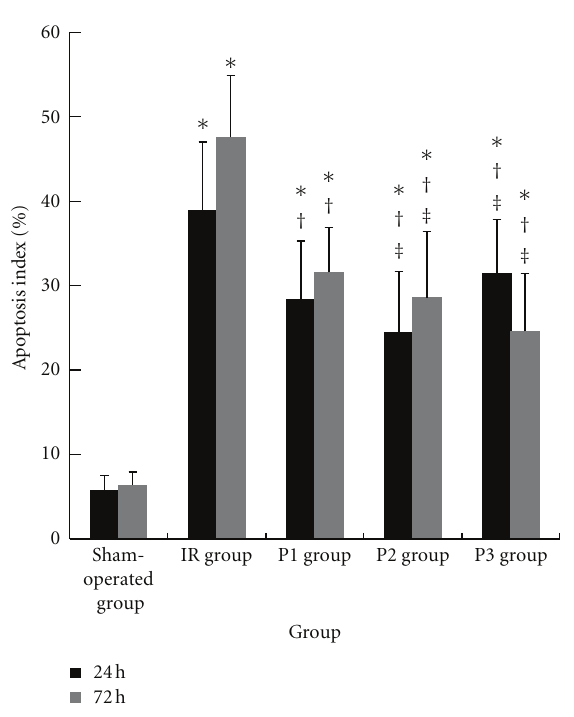
Figure 2: Apoptosis index in brain slices of five groups at 24 h and 72h. Data are presented as means ± SD. ∗ P < 0 . 01, versus sham- operated group. There were significant di ff erences of apoptosis index in IR, P1, P2, P3 groups than that in sham-operated group; † P < 0 . 05, versus IR group. There were significant di ff erences of apoptosis index in P1, P2, P3 groups than that in IR group; ‡ versus P1 group. There were significant apoptosis in P2 and P3 groups. But, in 72h, there was no obvious di ff erence between P2 and P3 group.